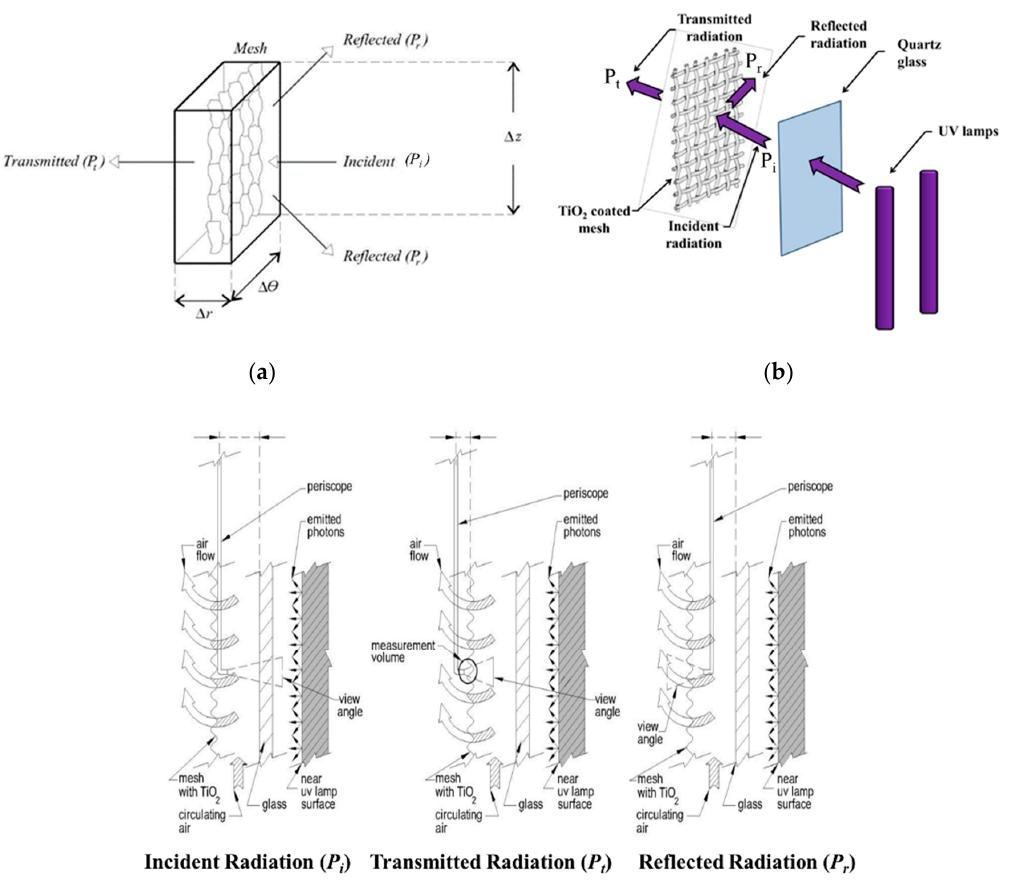
Figure 19. Photo-CREC-Air Reactor: ( a ) schematic diagram of the selected control volume for the macroscopic local radiation energy balance, ( b ) photon trajectory description for near-UV lamps; photons traverse the quartz glass and reach the woven SS mesh and ( c ) optical probe locations inside the PCAR for radiation measurements. Reproduced with permission of Applied Catalysis B: Environmental [12].